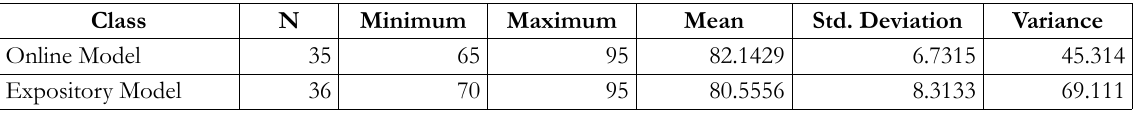
Table 10. Initial Mathematic connection